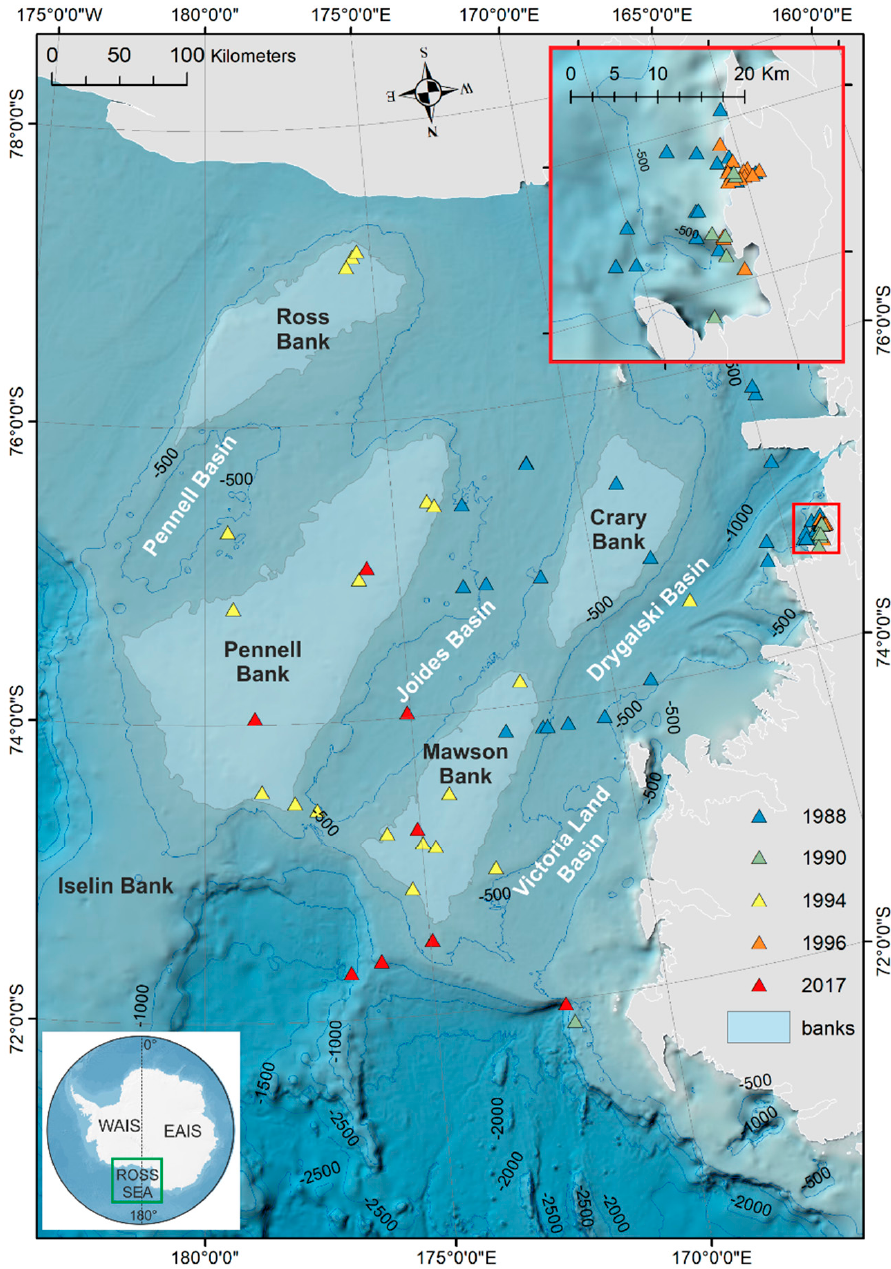
Figure 1. Study area with locations of the surficial sediment samples collected during different oceanographic cruises (see Table S1 in Supplementary Materials). The green triangle denotes samples collected during the oceanographic cruises 1990–1991; yellow triangle, the oceanographic cruises 1994–1995. Samples collected in TNB (red square) are reported in the inset. Map created using the IBCSO bathymetry [90]. Isobaths every 500 m.